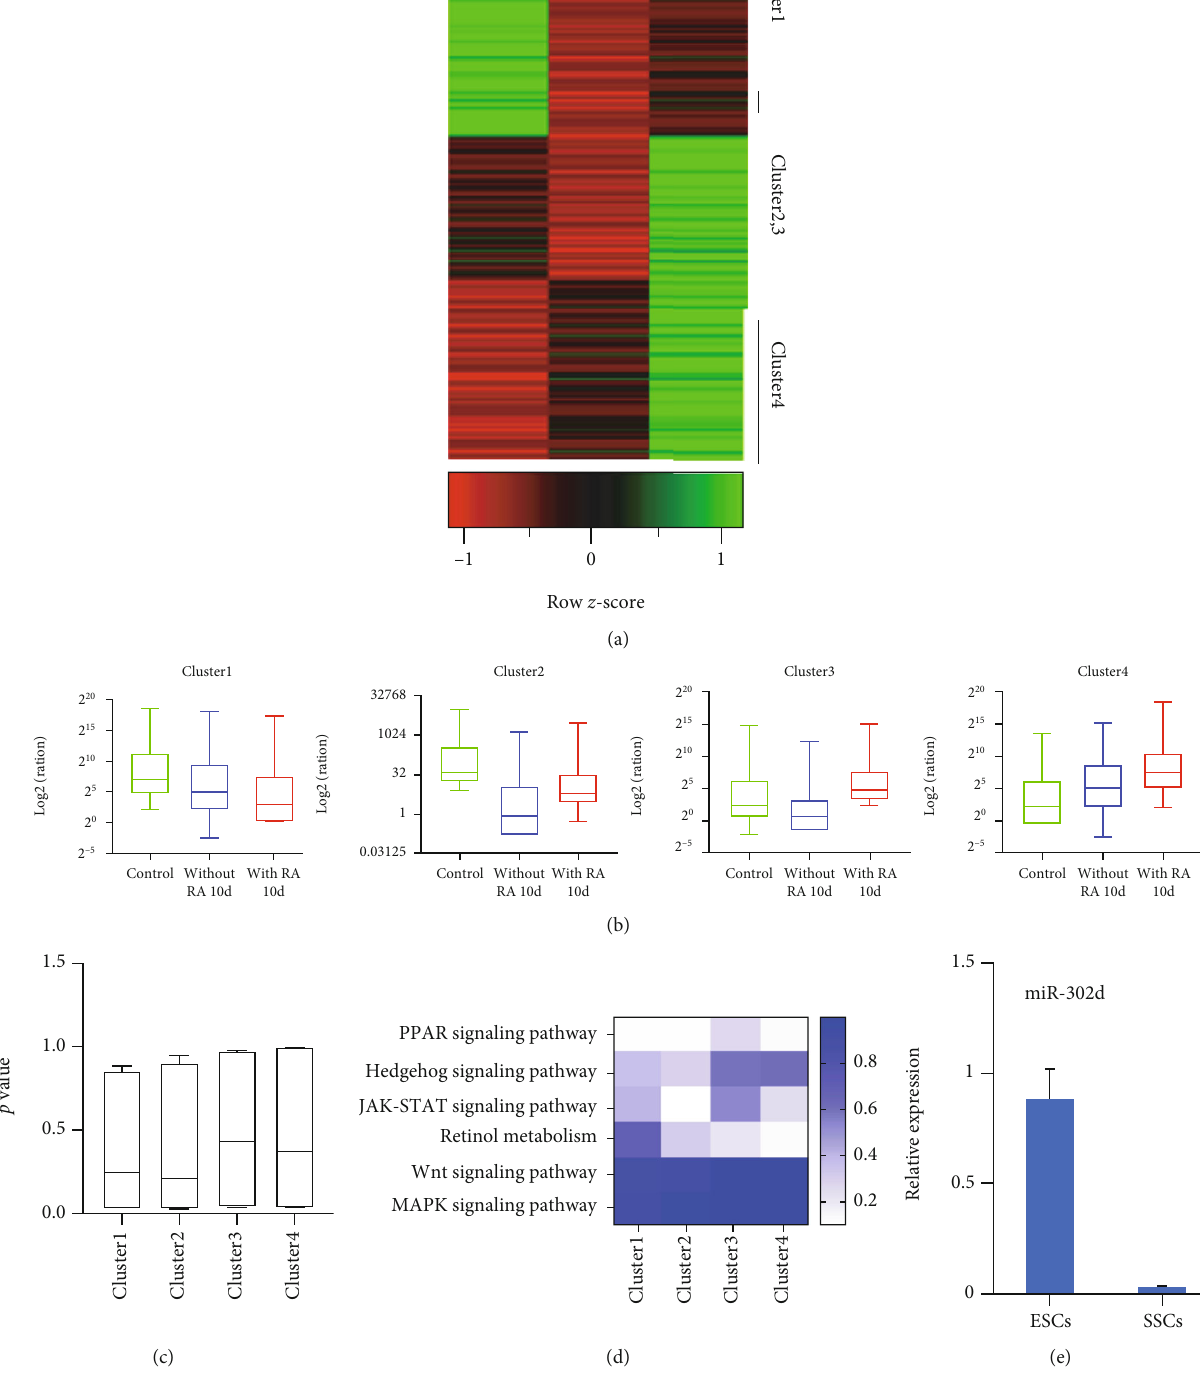
Figure 1: Screening of miRNA-302d during RA-induced ESC di ff erentiation into SSCs. (a) Di ff erential miRNA thermogram. (b) Box diagram analysis of K -means clustering. (c) GO analysis results. (d) KEGG analysis results. (e) Expression trends of miR-302d in ESCs and